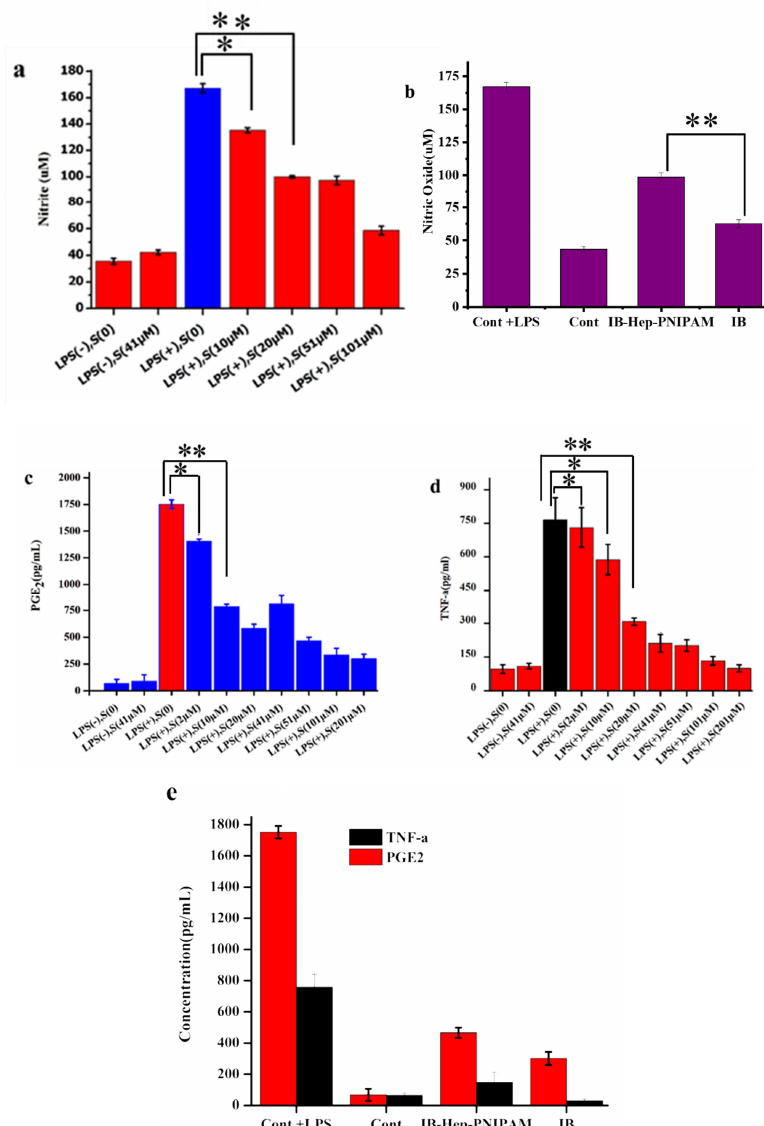
Figure 6. Effects of various concentrations of IB-Hep-PNIPAM on LPS-induced NO, PGE 2 , and TNF- α secretion in RAW264.7 cells. ( a ) NO, ( b ) effects of free ibuprofen compared with those of IB-Hep-PNIPAM and control on the production of NO, ( c ) PGE 2 , and ( d ) TNF-α, and ( e ) effects of free ibuprofen compared with IB-Hep-PNIPAM and control on PGE 2 and TNF-α production. Data are presented as means ± SD of three independent experiments: * p < 0.05, ** p < 0.01 vs. LPS without sample.